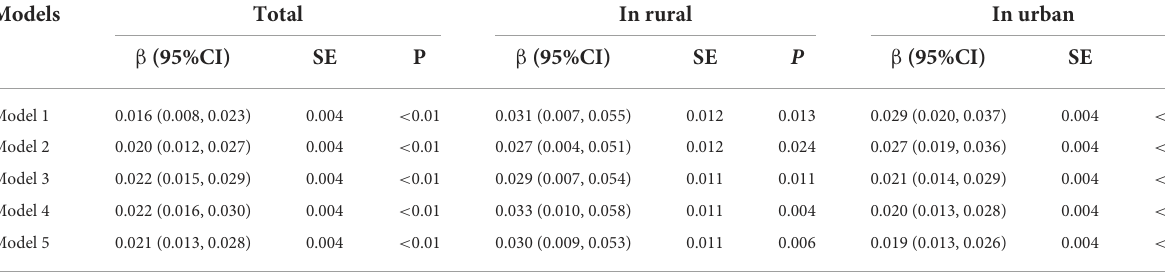
TABLE 4 The linear association between remnant cholesterol (RC) and waist-to-height ratio (WHtR). Models